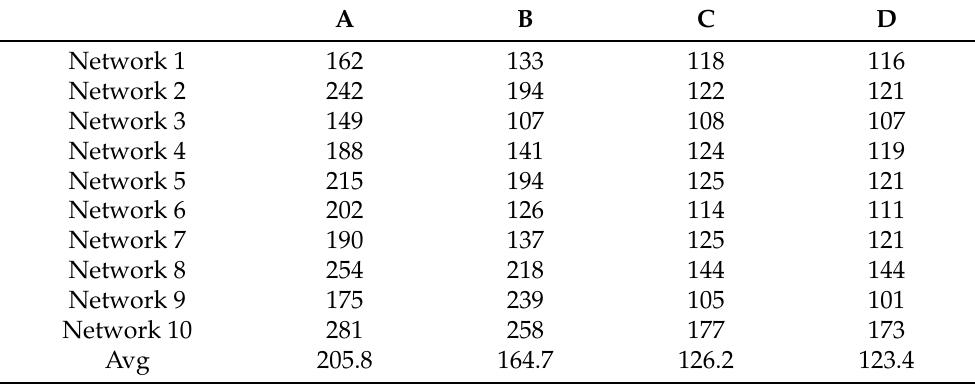
Table 4. Optimized frame sizes for large